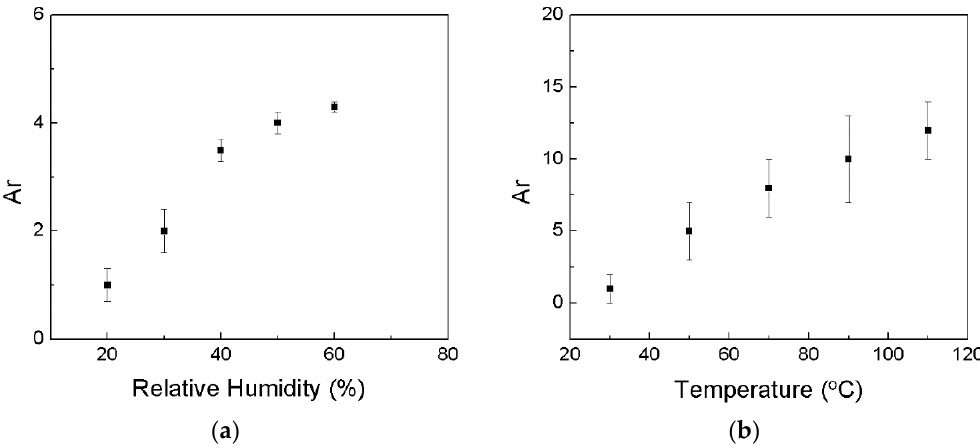
Figure 3. The e ff ect of relative humidity ( a ) and temperature ( b ) on the sensor Figure 3. The effect of relative humidity ( a ) and temperature ( b ) on the sensor resistance.